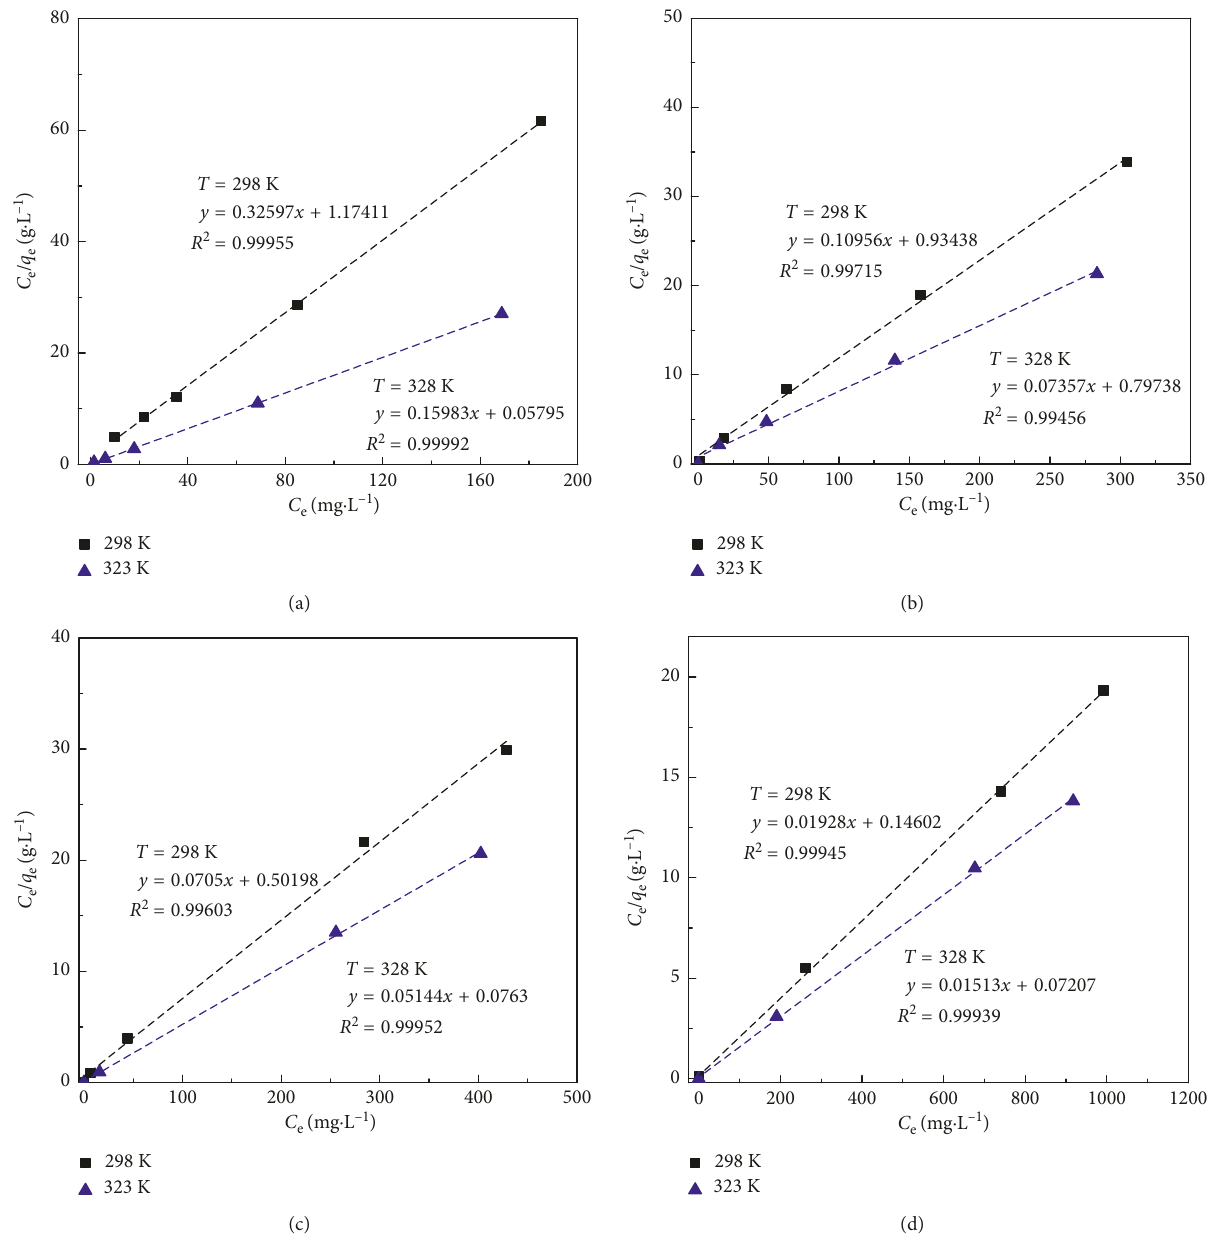
Figure 8: Langmuir fitting curves of Pb(II) adsorption: (a) ω